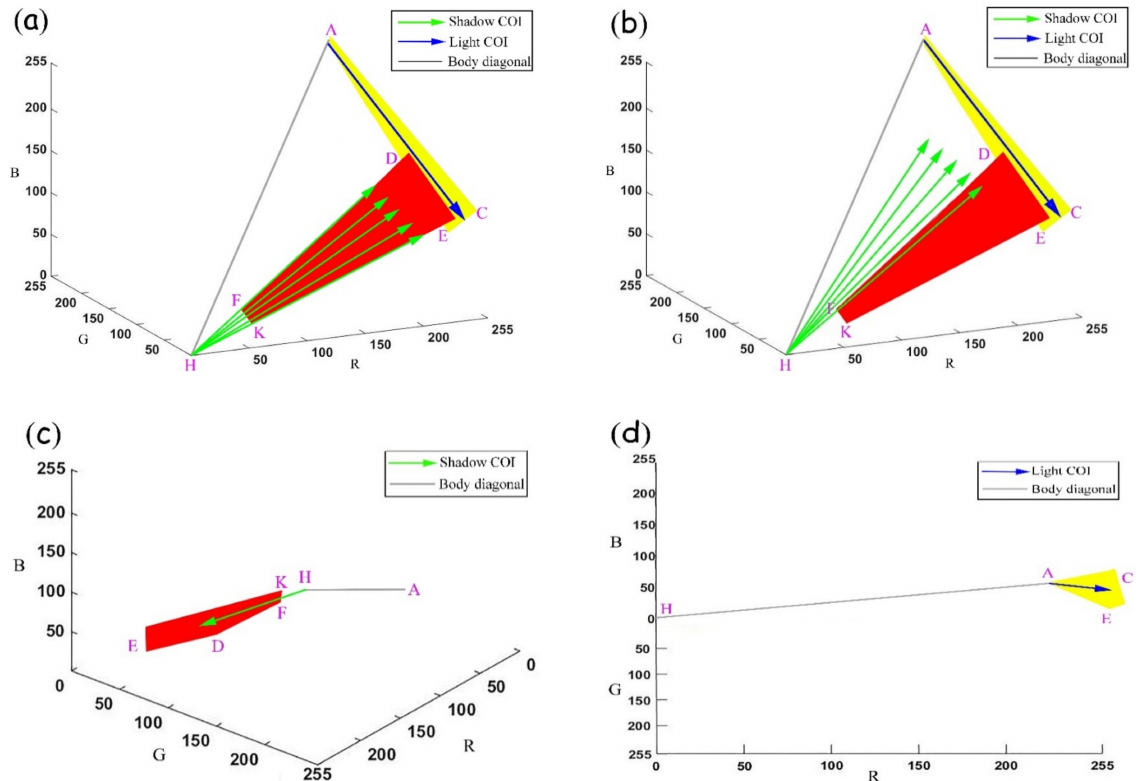
Figure 4. Distribution of the apple’s red in the RGB color space. ( a ) Selection of halation and shadow COIs, ( b ) Results of the shadow COI after rotation, ( c ) Apple image divided vertically along the pixel distribution map of the rotated shadow COI, ( d ) Apple image divided vertically along the pixel distribution map of the halation